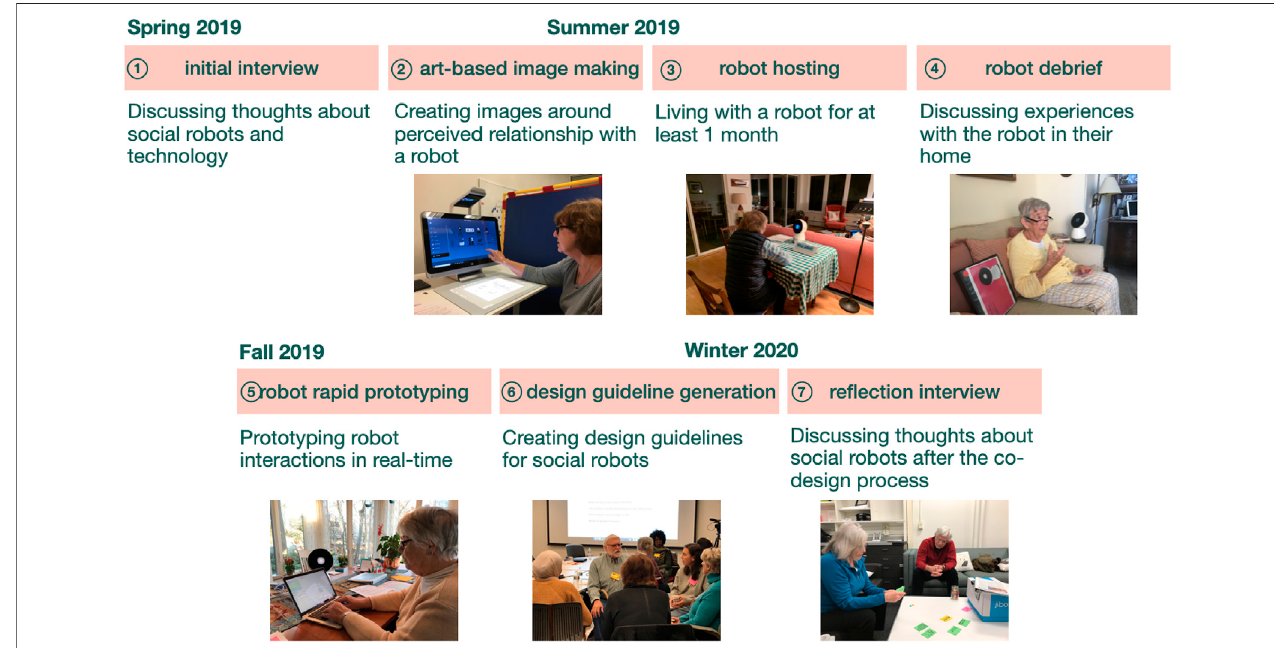
FIGURE 1 | Co-design process, brief descriptions about the sessions, and timeline depicting the seven stage process to design social robots.